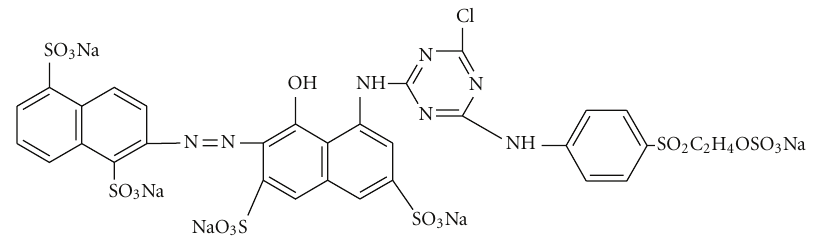
Scheme 1: Chemical structure of RR